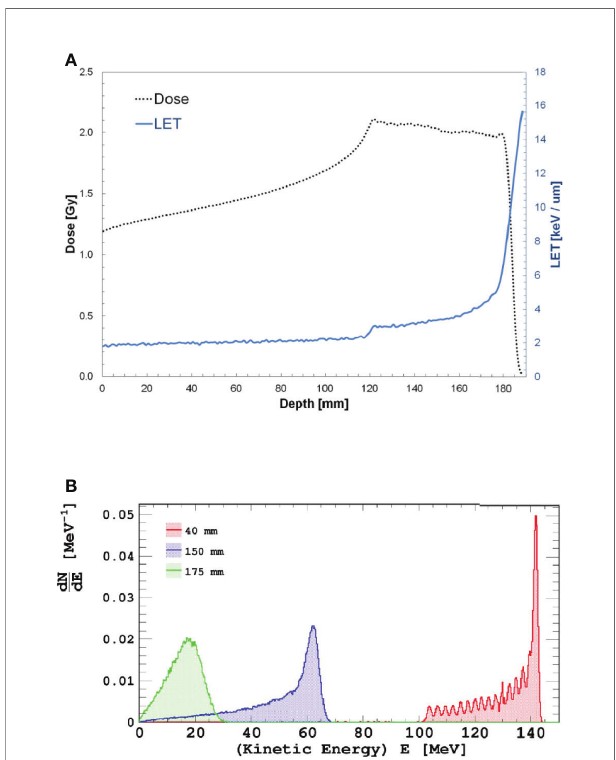
FIGURE 2 | Top panel (A) : Dose- and LET-depth pro fi les for the CNAO SOBP used during the cellular irradiations. Bottom panel (B) : Incident proton distributions at the three positions where cells were irradiated; from right to left, energy distribution at entrance, mid-and distal